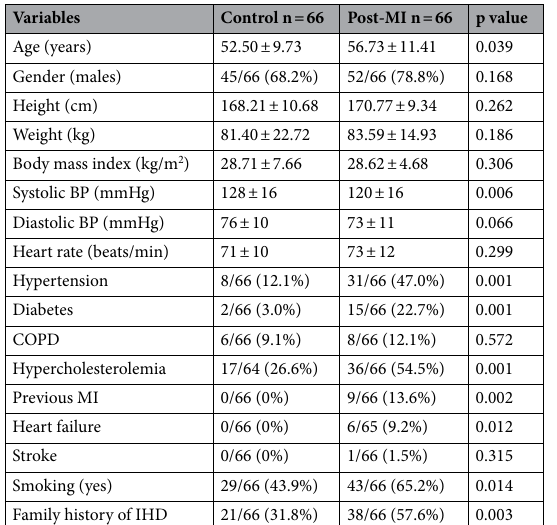
Table 1. Demographic and clinical characteristics (mean ± SD). COPD chronic obstructive pulmonary disease, IHD ischaemic heart disease, BP blood